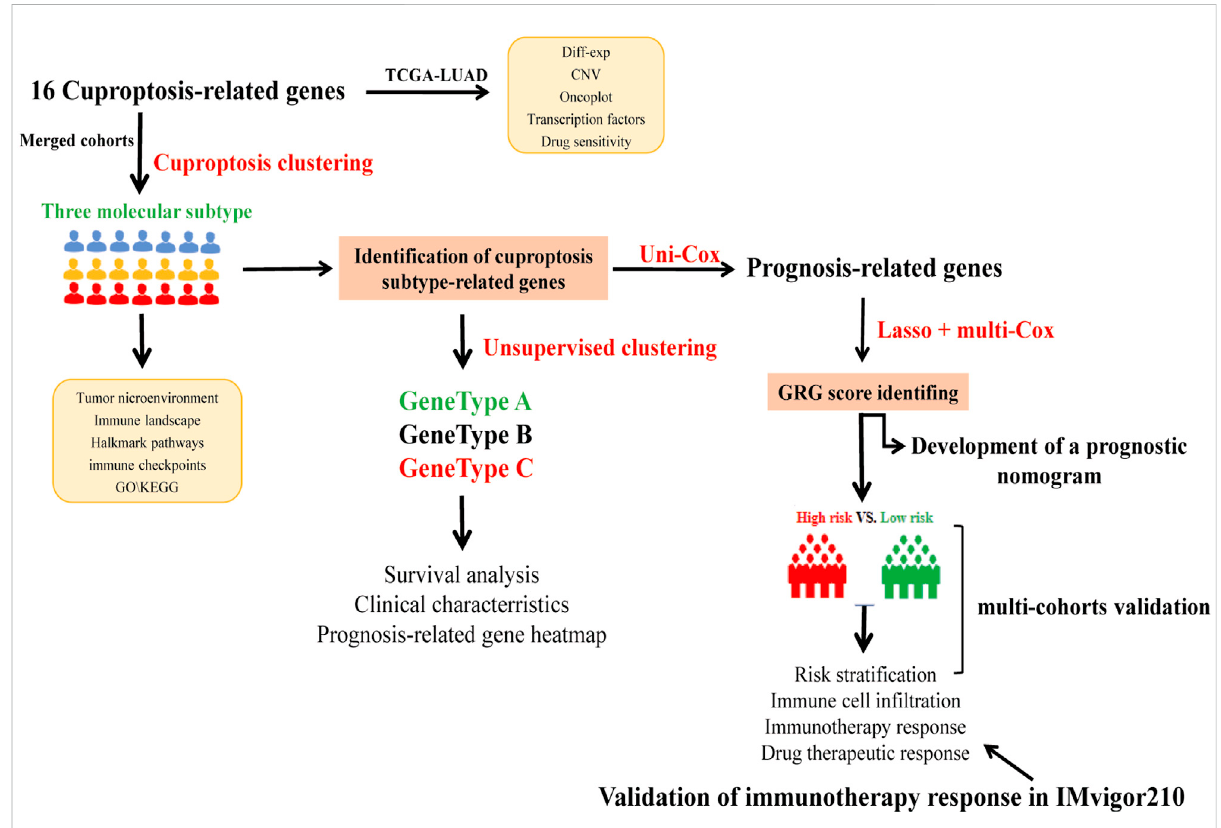
FIGURE 1 The fl ow diagram showed the entire analytical process of the